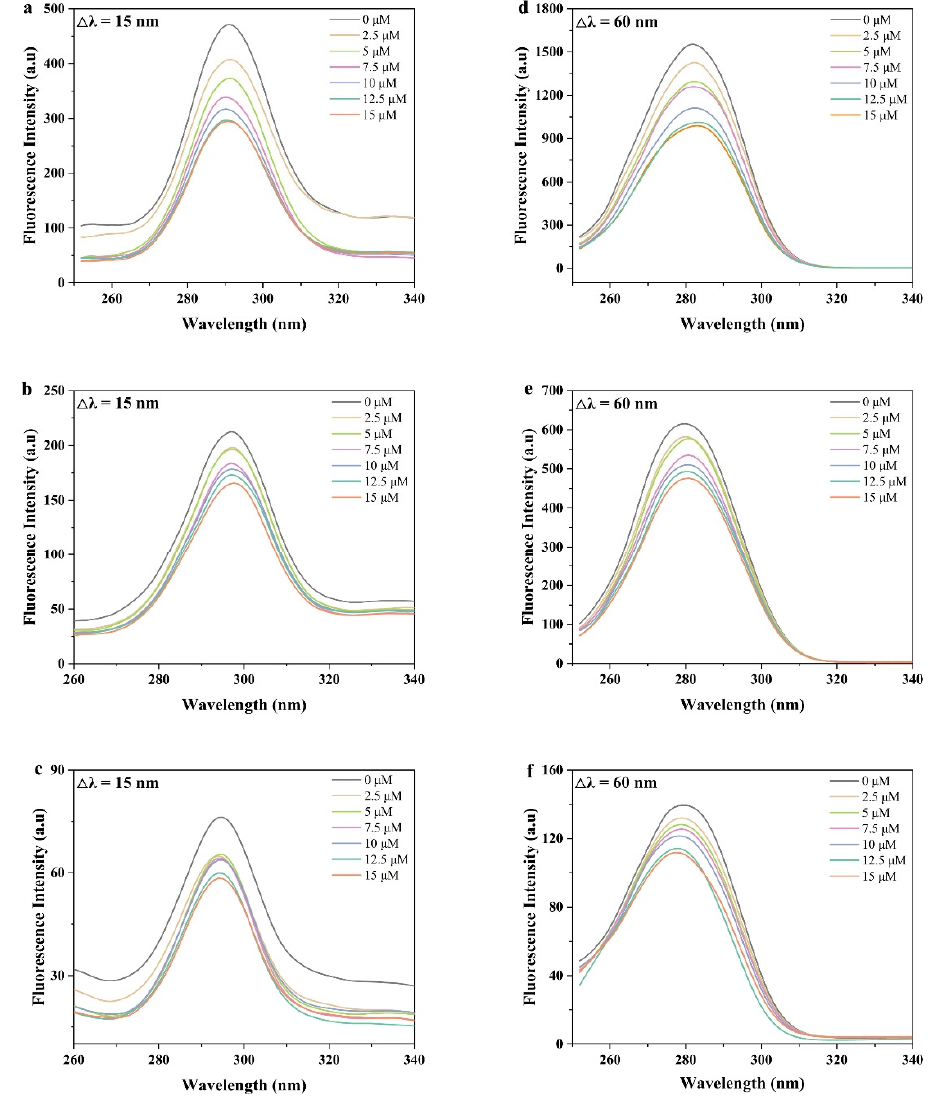
Figure 3. Synchronous fluorescence spectra of BSA ( a , d ), β -Lg ( b , c ) and α -La ( d , e ) in the presence of different concentrations of TF1 at 298 K and pH 7.4. ∆ λ is the interval between excitation and emission wavelength.